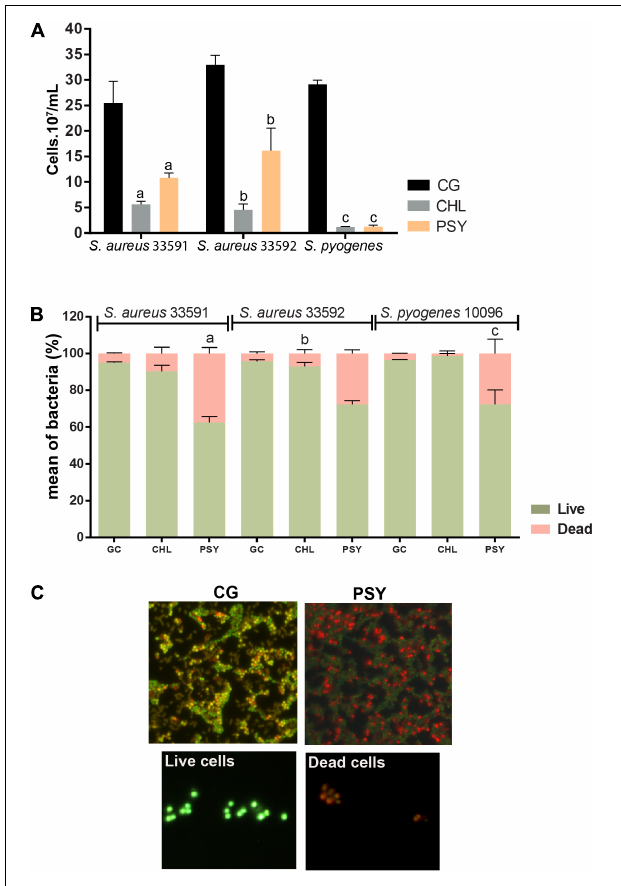
FIGURE 3 | Effect of psychorurin (PSY) on the growth of S. aureus 33591, S. aureus 33592 and S. pyogenes 10096. Cultured bacteria were stained with DAPI or LIVE/ DEAD R (cid:13) BacLight TM and counted under fluorescence microscopy for evaluation of cell density (A) and viability (B,C) , respectively. Psychorubrin treatment induced both decrease of cell density (A) and increase of cell death (B) compared to control groups treated with psychorubrin vehicle. (C) Representative images from S. aureus 33501 show dead cells in red and live cells in green after baclight staining. Letters indicate statistical difference from controls treated with psychorubrin vehicle for S. aureus 33591 ( a ), S. aureus 33592 ( b ), S. pyogenes 10096 ( c ) (ANOVA followed by Bonferroni, P < 0.05). Chloramphenicol (CHL) was used as a positive control. All experiments were carried out in triplicate, and data represent the mean ± SD of bacteria